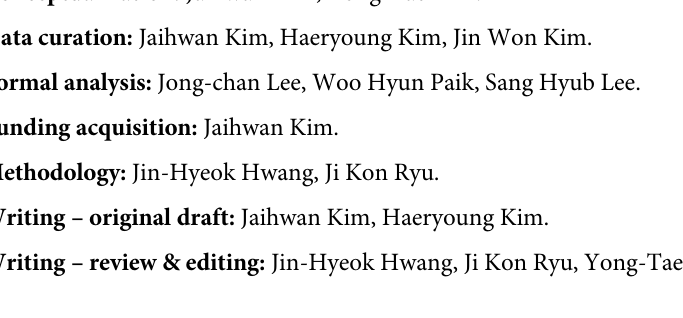
S1 Fig. Cell viability after gemcitabine treatment in four biliary tract cancer (BTC) cell lines. S1 Table. Clinical dataset of enrolled patients.